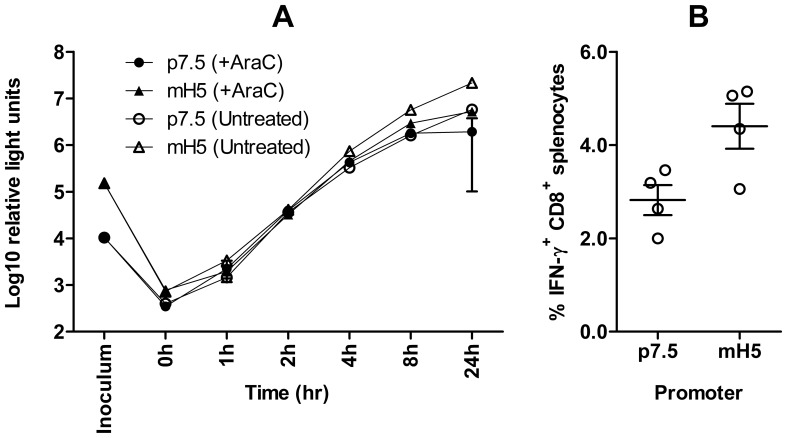
(A) Timecourse of activity of mH5 promoter compared to p7.5 in vitro. BHK cells were “spinoculated” (see Materials and Methods) with 1 pfu/cell of recombinant MVA carrying tPA-Pb9-rLuc8PV under the control of the indicated promoters. Renilla luciferase activity was quantified in the inoculum and then in the culture supernatant at various time points post-infection. Cells were either untreated or exposed to 40 µM AraC during and after infection as indicated, to inhibit post-replicative gene expression. Data shown are the mean and standard deviation of duplicates. The data shown are representative of two independent experiments. (B) Cellular immunogenicity of recombinant MVA antigen (tPA-Pb9-rLuc8PV) driven by mH5 compared to p7.5 in a single-shot vaccination regimens. BALB/c mice were immunized i.m. with 106 pfu rMVA and splenic CD8+ T cell responses to Pb9 peptide were determined 7 days later by intracellular cytokine staining and flow cytometry. Circles represent the responses of individual mice, with lines indicating the mean and the error bars showing SEM. See text for statistical analysis. The data shown are representative of two independent experiments.